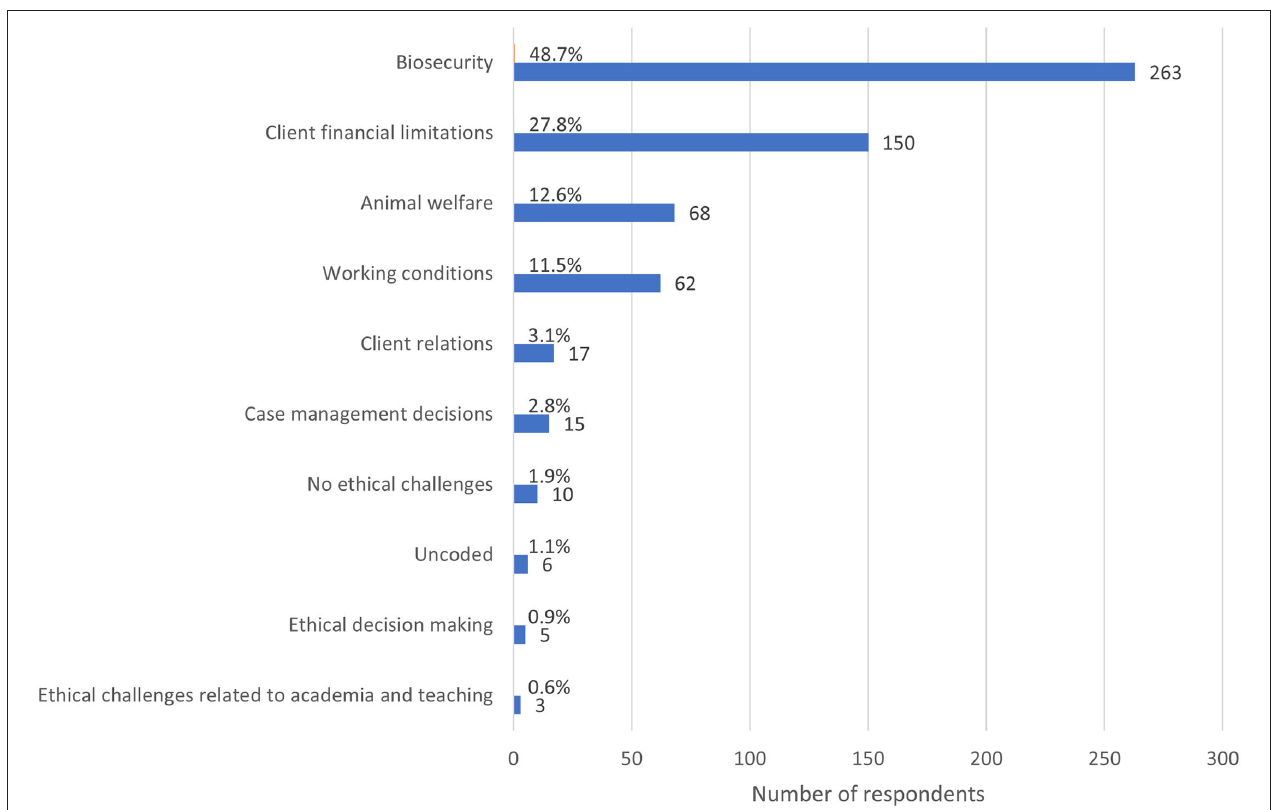
FIGURE 8 | Bar chart of the frequency of major themes from respondent descriptions of the most common ethically challenging situations encountered since the advent of the COVID-19 global pandemic, based on the responses of 540 veterinarians, animal health technicians and veterinary nurses, surveyed between May and July in 2020. Note that a single response could be coded for multiple